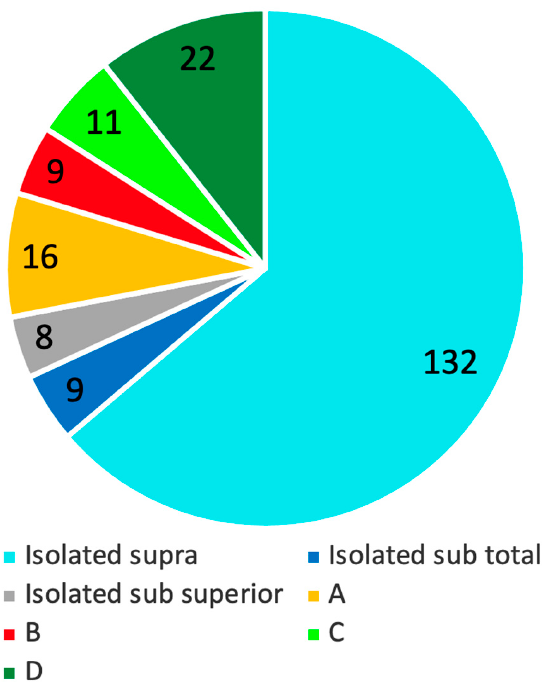
Figure 2. Tears distribution. A, supraspinatus and superior subscapularis tears; B, supraspinatus and entire subscapularis tears; C, supraspinatus, superior subscapularis, and infraspinatus tears; D, supraspinatus and infraspinatus tears.